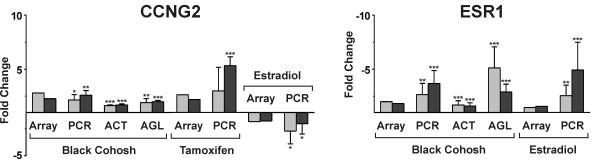
Gene expression levels of cyclin G2 (CCNG2) and estradiol receptor α (ESR1) in MCF-7 cells after 24 h treatment with black cohosh extract (15 μg/ml), the triterpene glycoside actein (20 μM), the triterpene aglycon mixture (30 μM), tamoxifen (10 μM) and estradiol (1 nM). For the treatments with extract, tamoxifen and estradiol, results obtained with microarrays (Array) and real-time RT-PCR (PCR) are shown. For actein (ACT) and the aglycons (AGL) expression levels were determined by real-time RT-PCR. Bars represent gene expression levels as fold changes calculated versus DMSO control. RT-PCR measurements were done at least in triplicate. The data are presented as means ± SD (*p < 0.05, **p < 0.01, ***p < 0.001: gene expression statistically significantly different from DMSO control, calculated by Student's t-test).